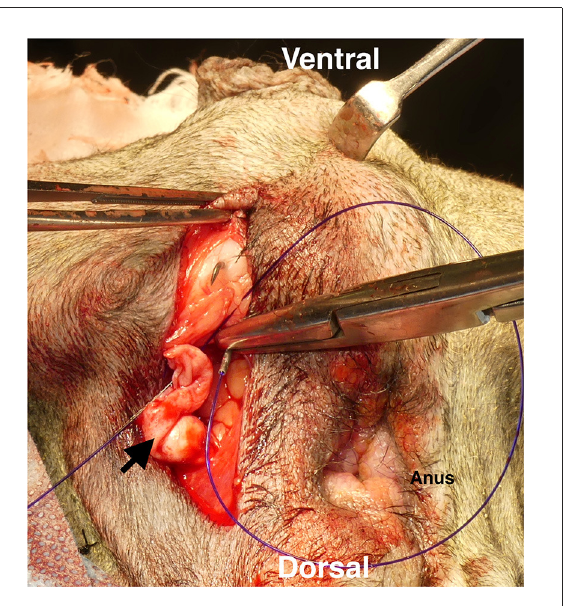
FIGURE5 Ligating the transposed tunica vaginalis communis (TVC) with the internal obturator muscle. First, TVC was ligated with sacrotuberous ligament at three-four sites. It was then ligated with the internal obturator muscle at three-four sites. Black arrow: transposed TVC.